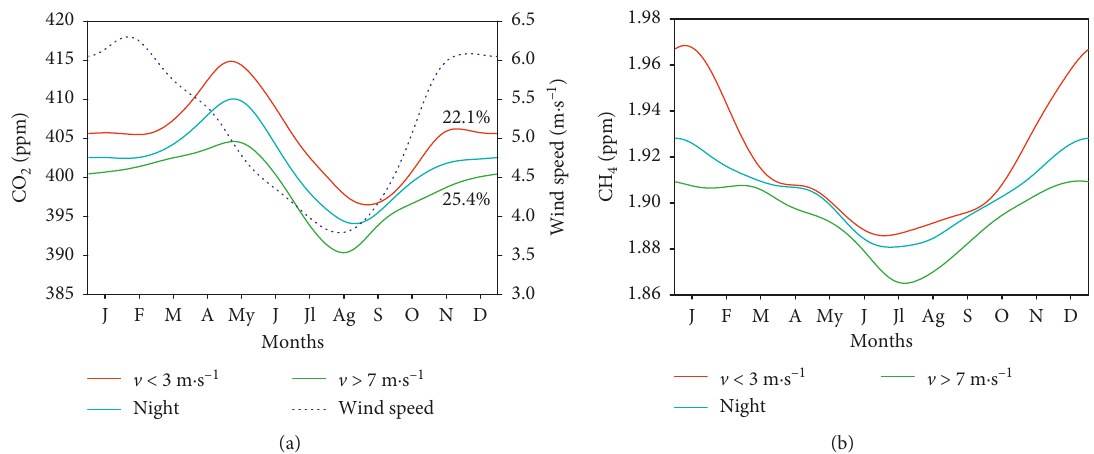
Figure 6: Annual evolution of wind speed and CO 2 (a) and CH 4 (b). Three situations were considered: with all the observations during the night (cyan line), for wind speed below 3m · s − 1 (red line), and for wind speed over 7m · s − 1 (green line). The appearance frequency for low and high wind is also shown. Table 7: Differences between average concentrations calculated with observations selected for different thresholds of wind speed and the annual cycle for nighttime observations. Availabilities and numbers of days without observations (gaps) are presented. Type of